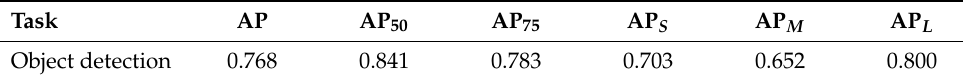
Table 5. Results of object detection.